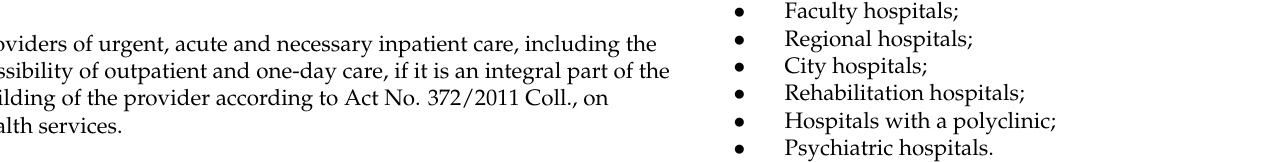
Table 2. Object selection